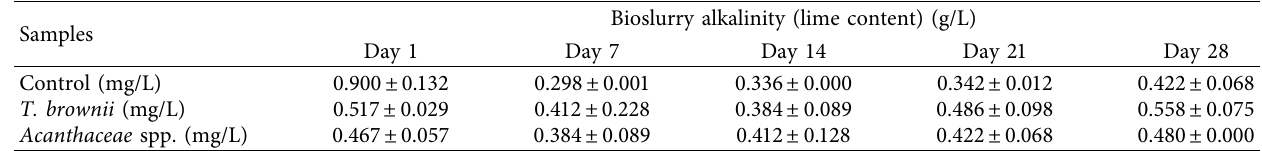
Table 4: Variation in lime content of the bioslurry over the retention